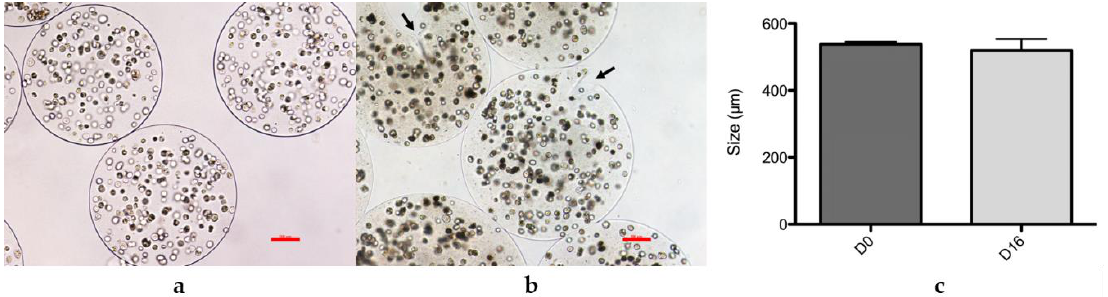
Figure 1. Morphology and size of microparticles at D0 and D16 after encapsulation. ( a ) Microparticles obtained for donor 16,023 at P3 at 4 × 10 6 cells / mL encapsulation solution, D0, optical microscopy images, 10 × magnification. Scale bar: 100 µ m. ( b ) Microparticles obtained for donor 16,023 at P3 at 4 × 10 6 cells / mL encapsulation solution, D16, optical microscopy images, 10 × magnification. Scale bar: 100 µ m. ( c ) Mean diameters ± standard deviation of microparticles from two donors at P3 and one donor at P3 and P4 ( n = 4) measured after encapsulation (D0) and after 16 days’ (D16) storage in culture medium. Diameters were calibrated using a micrometric ruler and were measured on photos taken with the optical microscope, using Image J software.